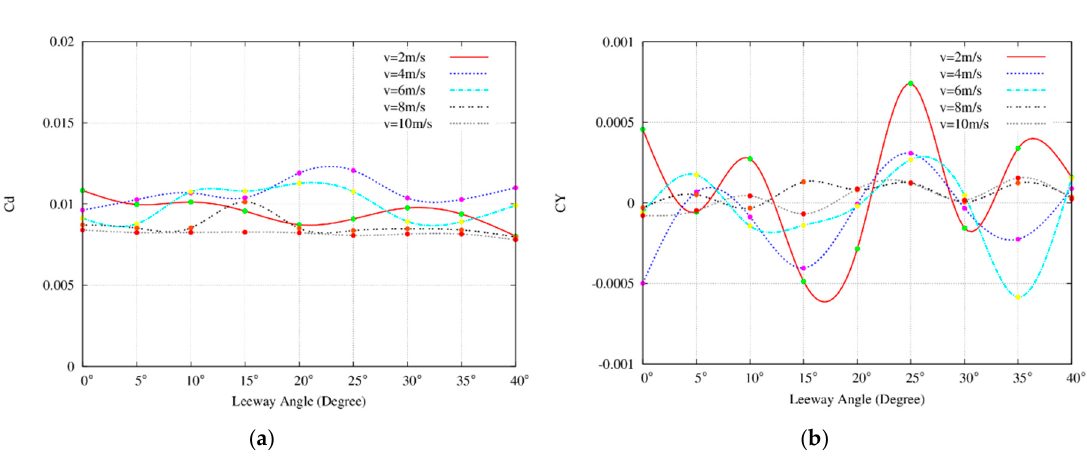
Figure 3. The result of relation between hull force coefficient and leeway angle: ( a ) is hull drag and ( b ) is lateral